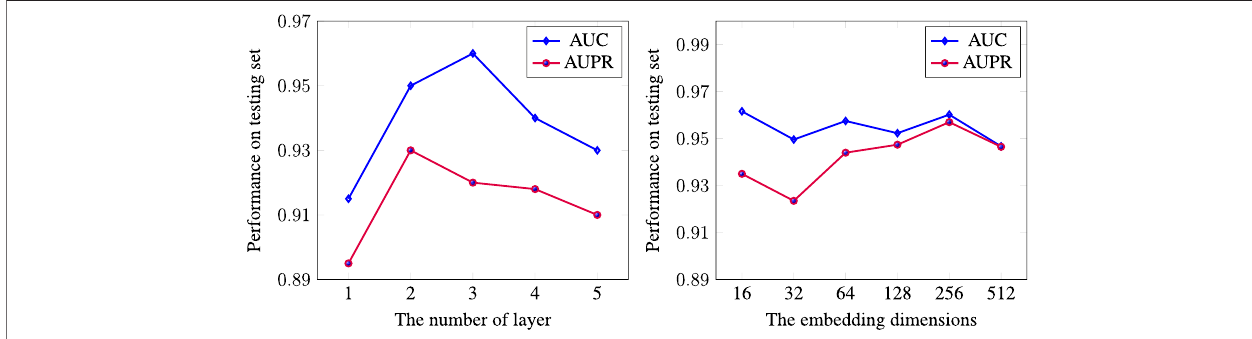
FIGURE 3 | Impact of the number of layers and embedding dimension on the model performance.